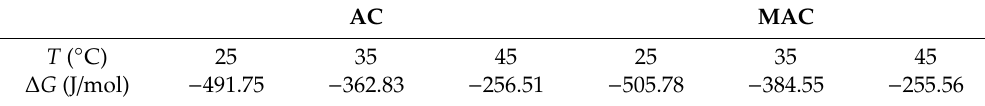
Table 6. Gibbs free energy change at 25, 35, and 45 ◦ C for AC and MAC.